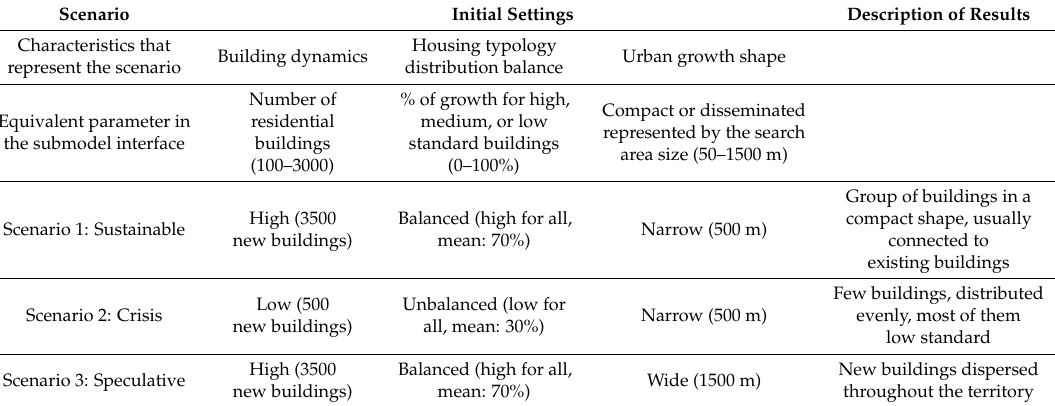
Table 3. Initial settings and description of submodel spatial results from simulation of the three developer scenarios.